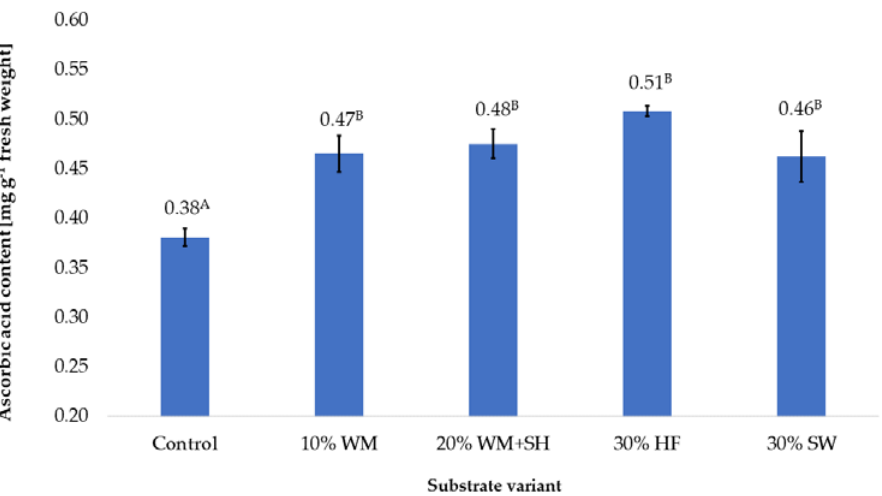
Figure 6. Vitamin C content in raspberry fruits, depending on the substrate used (n = 36). Note: Significant differences between the results, depending on the substrate variant used, are marked with different letters. Significant level at p < 0.05. Key: Control—100% coconut fibre; 10% WM—90% coconut fibre + 10% fragmented wood material; 20% W M + SH—80% coconut fibre + 10% frag-